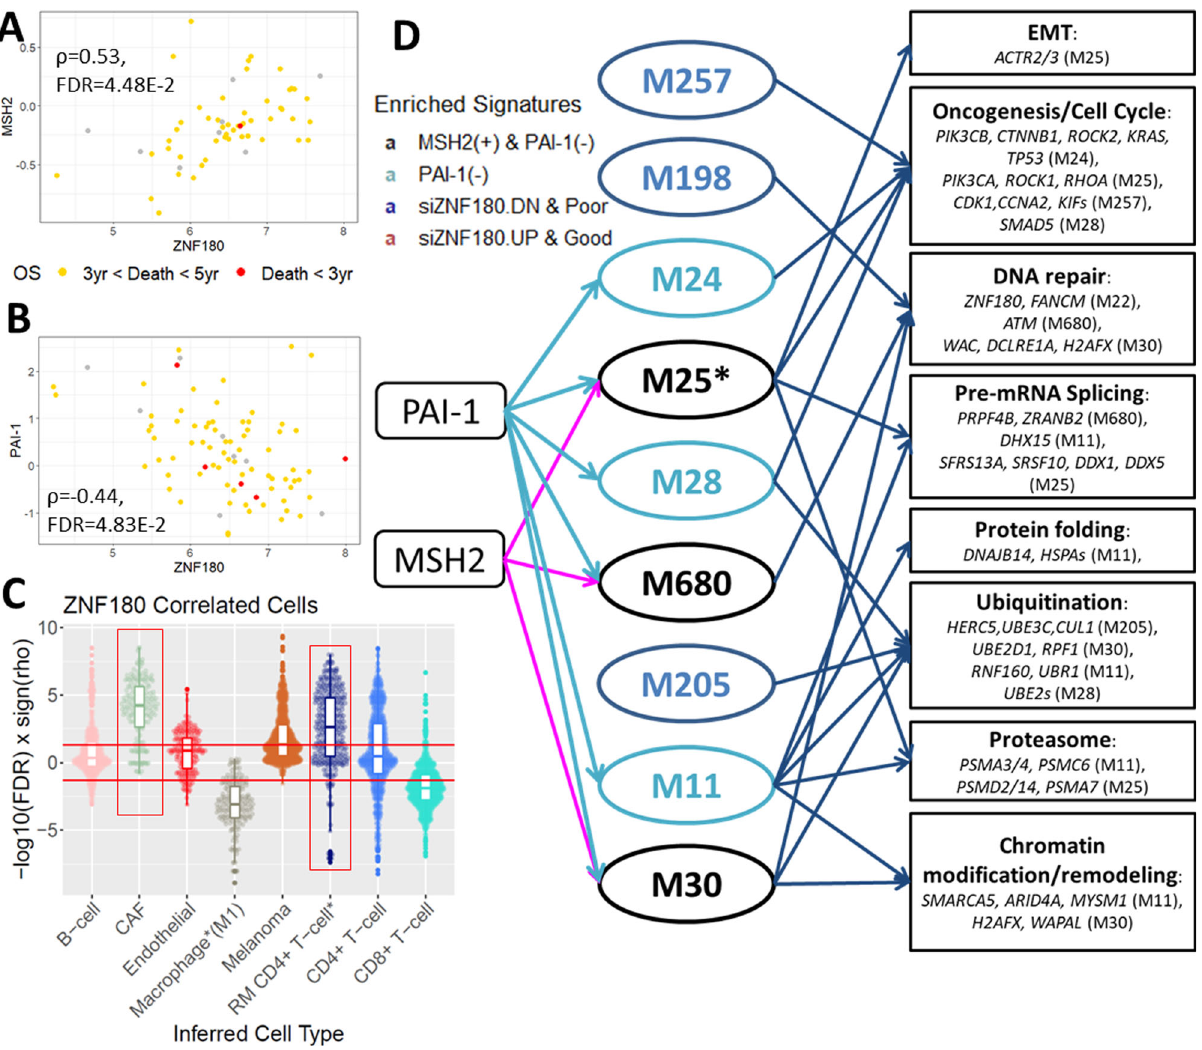
Fig. 4 Dissection of ZNF180 -regulated pathways in melanoma. A , B Correlations between ZNF180 expressions ( x -axis) and protein expressions ( y -axis; A : MSH2, B : PAI-1) by RPPA. Dot color indicates patients ’ prognosis in overall survival (death within 3 years of follow-up: red, otherwise yellow). C Cell abundance is correlated with ZNF180 expressions in pSKCM. The relative abundance of 4645 cells with annotated cell types (in x -axis) were inferred across 103 pSKCM samples by cell population mapping (CPM) algorithm in the scBio package. The inferred abundance was then tested for correlation with ZNF180 expressions in pSKCM. Each dot represents the correlation between the relative abundance of one cell from the scRNA-seq with ZNF180 expressions in pSKCM. the x -axis is cell types of the respective cells, and the y -axis is − log10(FDR) signed by Spearman ’ s correlation coef fi cient. The red horizontal lines mark FDR = 0.05 threshold, and red rectangles highlight the most distinctively correlated cell types. The border of a boxplot show the lower quantile, median, or upper quantiles while a whisker spans towards the minima and the maxima. D Summary of the pathways associated with the modules potentially regulated by ZNF180 . Enriched signatures in the modules are